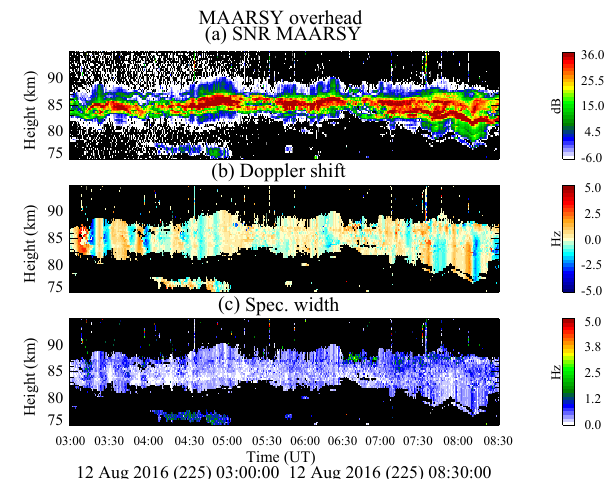
Figure 4. PMSE height–time observations using MAARSY for transmission and reception on 12 August 2016: (a) signal-to-noise ratio (SNR), (b) Doppler shift (Hz), and (c) spectral width